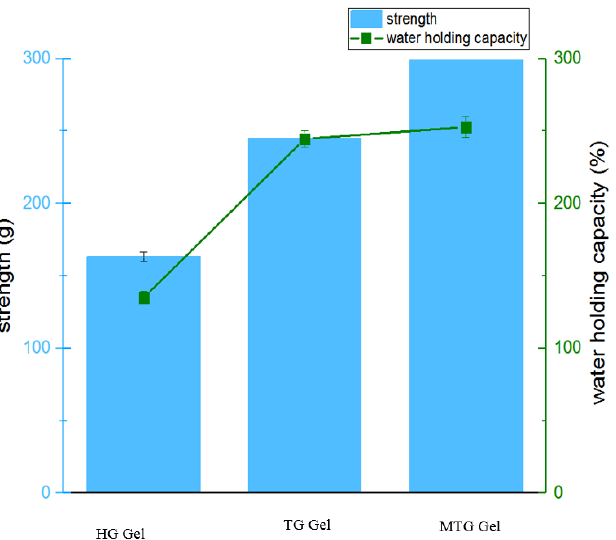
Figure 8. Gel strength and water-holding capacity of different induced gels.